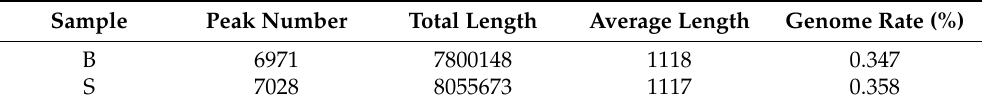
Figure 2. Summary of peaks ( A ) Motif sequence diagram; ( B ) Distribution of peaks in adipose tissue; ( C ) Distribution of peaks in muscle tissue. (‘B’ refers to the longest dorsal muscle and ‘S’ refers to perirenal fat). Table 2. Summary of peaks.